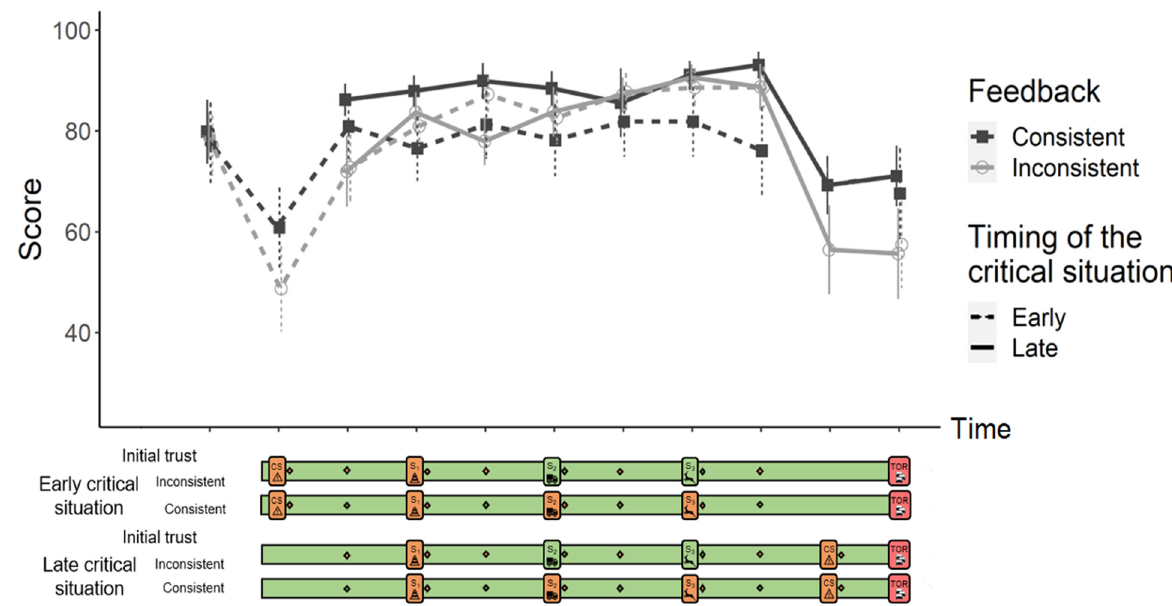
Figure 4. Evolution of drivers’ level of trust during the drive, depending on the timing of the critical situation and the feedback consistency (error bars: standard error).